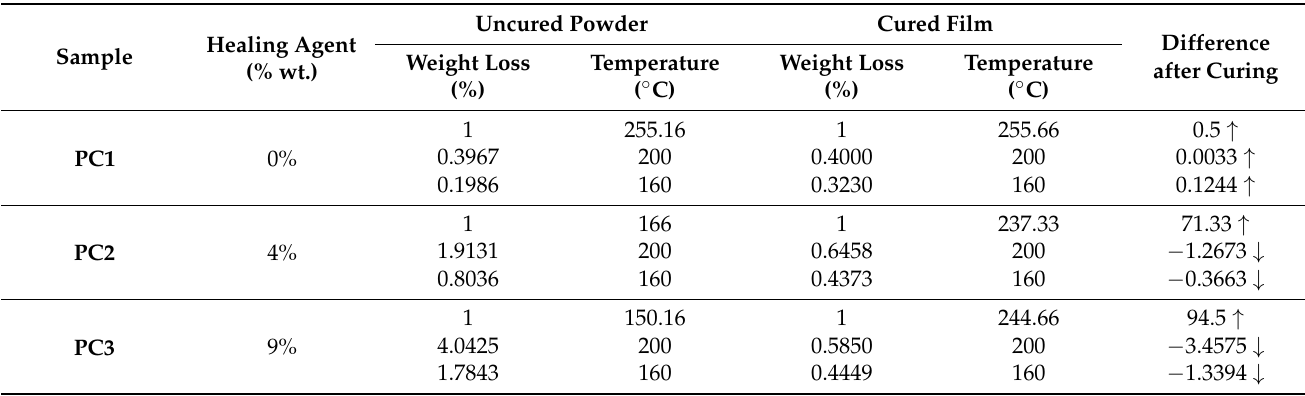
Figure 3. TGA curve comparing thermal degradation behavior of powder materials as well as the healing agent ( a ) and their cured films ( b ). Table 1. TGA data for uncured powder and cured coatings containing 4% wt. and 9% wt. HA and reference sample (cured at 160 ◦